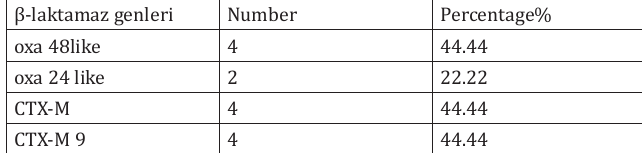
β -lactamase genes amplified by PCR in K. pneumonia (9)